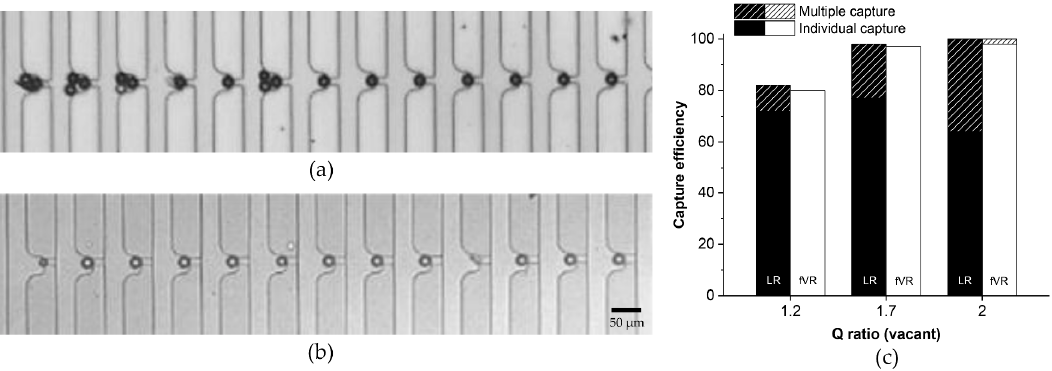
Figure 4. Demonstration of the deterministic polystyrene (PS) particle capture: ( a ) optical image of the particle capture for an LR-type and ( b ) an fVR-type device; ( c ) capture efficiency of the LR- and fVR-type devices regarding various Q ratios. The graph also shows the individual capture rate.